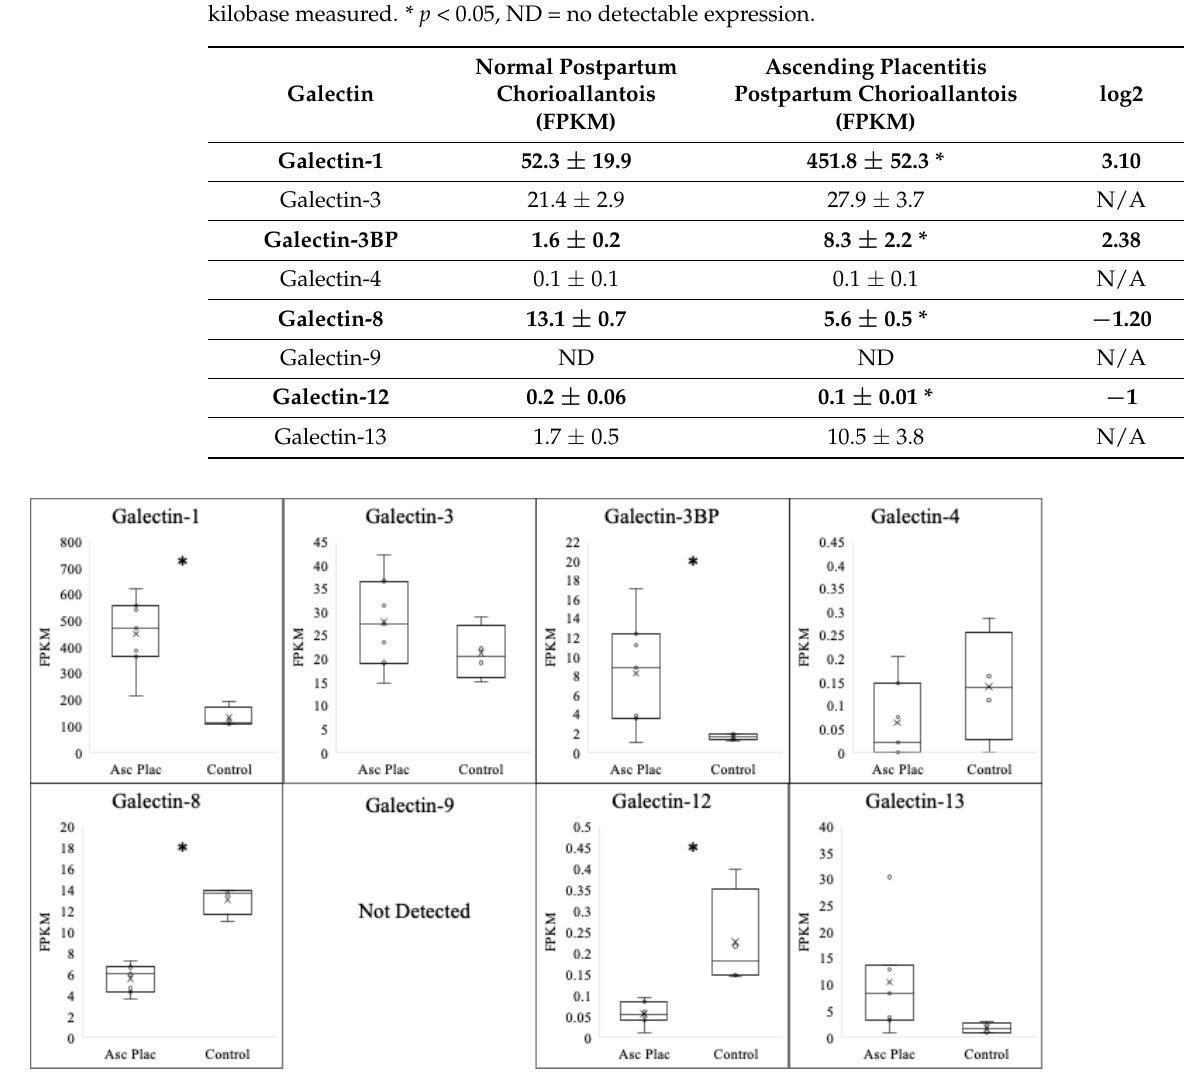
Figure 1. Expression profile of various galectins following ascending placentitis. Expressions of galectin-1 and galectin-3BP increased ( p < 0.05) following ascending placentitis in postpartum chorioallantois, while expressions of galectin-3, galectin-4, and galectin-13 were unchanged. In contrast, expressions of galectin-8 and galectin-12 significantly decreased in the ascending placentitis group compared with those of controls. Expression of galectin-9 was not above the FPKM threshold for detection. * p < 0.05. Table 1. Expression of various galectins following ascending placentitis. FPKM = fragments per kilobase measured. * p < 0.05, ND = no detectable expression.